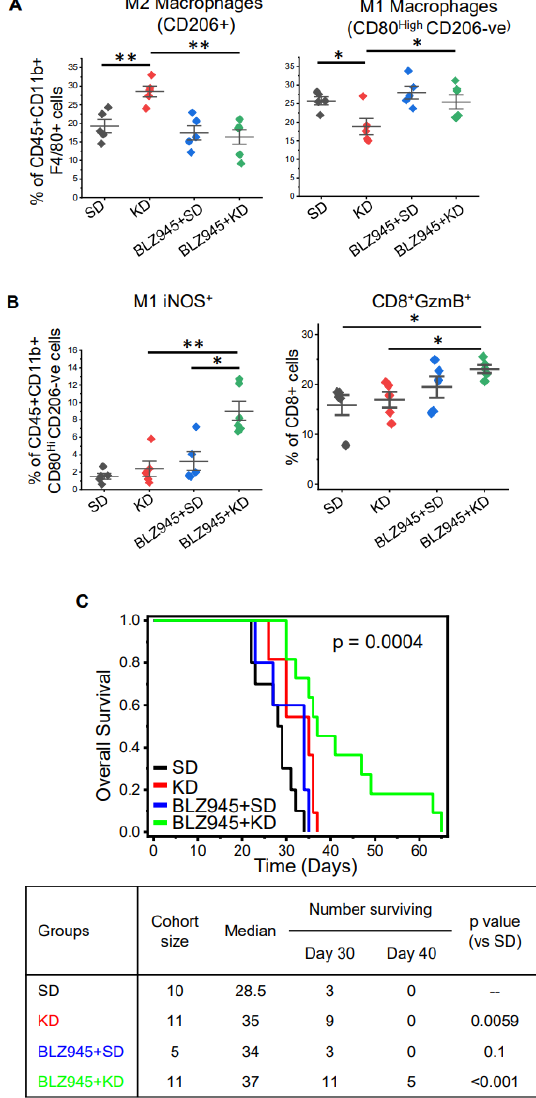
Figure 4. Targeting macrophage polarization through CSF-1 inhibition enhances the anti-tumor activity of a KD. TRP tumors were grown orthotopically in immune-competent C57BL/6 mice. Tumor establishment was confirmed using MRI. Mice were fed a standard diet (SD) or ketogenic diet (KD) ± CSF-1 inhibitor BLZ945. ( A , B ) Tumors were harvested on day 25 and immunophenotyped for indicated cells via flow cytometry (n = 5–6/group). ( C ) Kaplan–Meier survival plot in mice treated with the indicated agents (n = 7–10/group). Table describes cohort size, median survival, number of mice surviving on days 9, 30, and 40, and log rank p value between different groups when compared to SD group. The line between the data points represents the mean, and the whisker represents SE. *: p < 0.05, **: p <